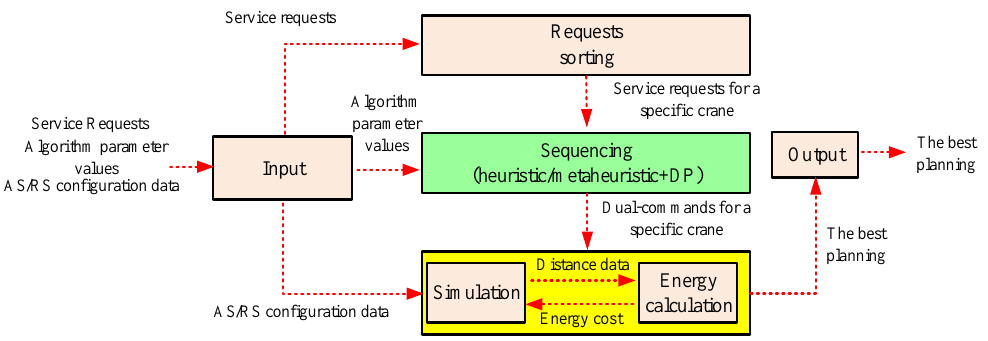
Figure 6. The workflow diagram of modules with input and output data flows.